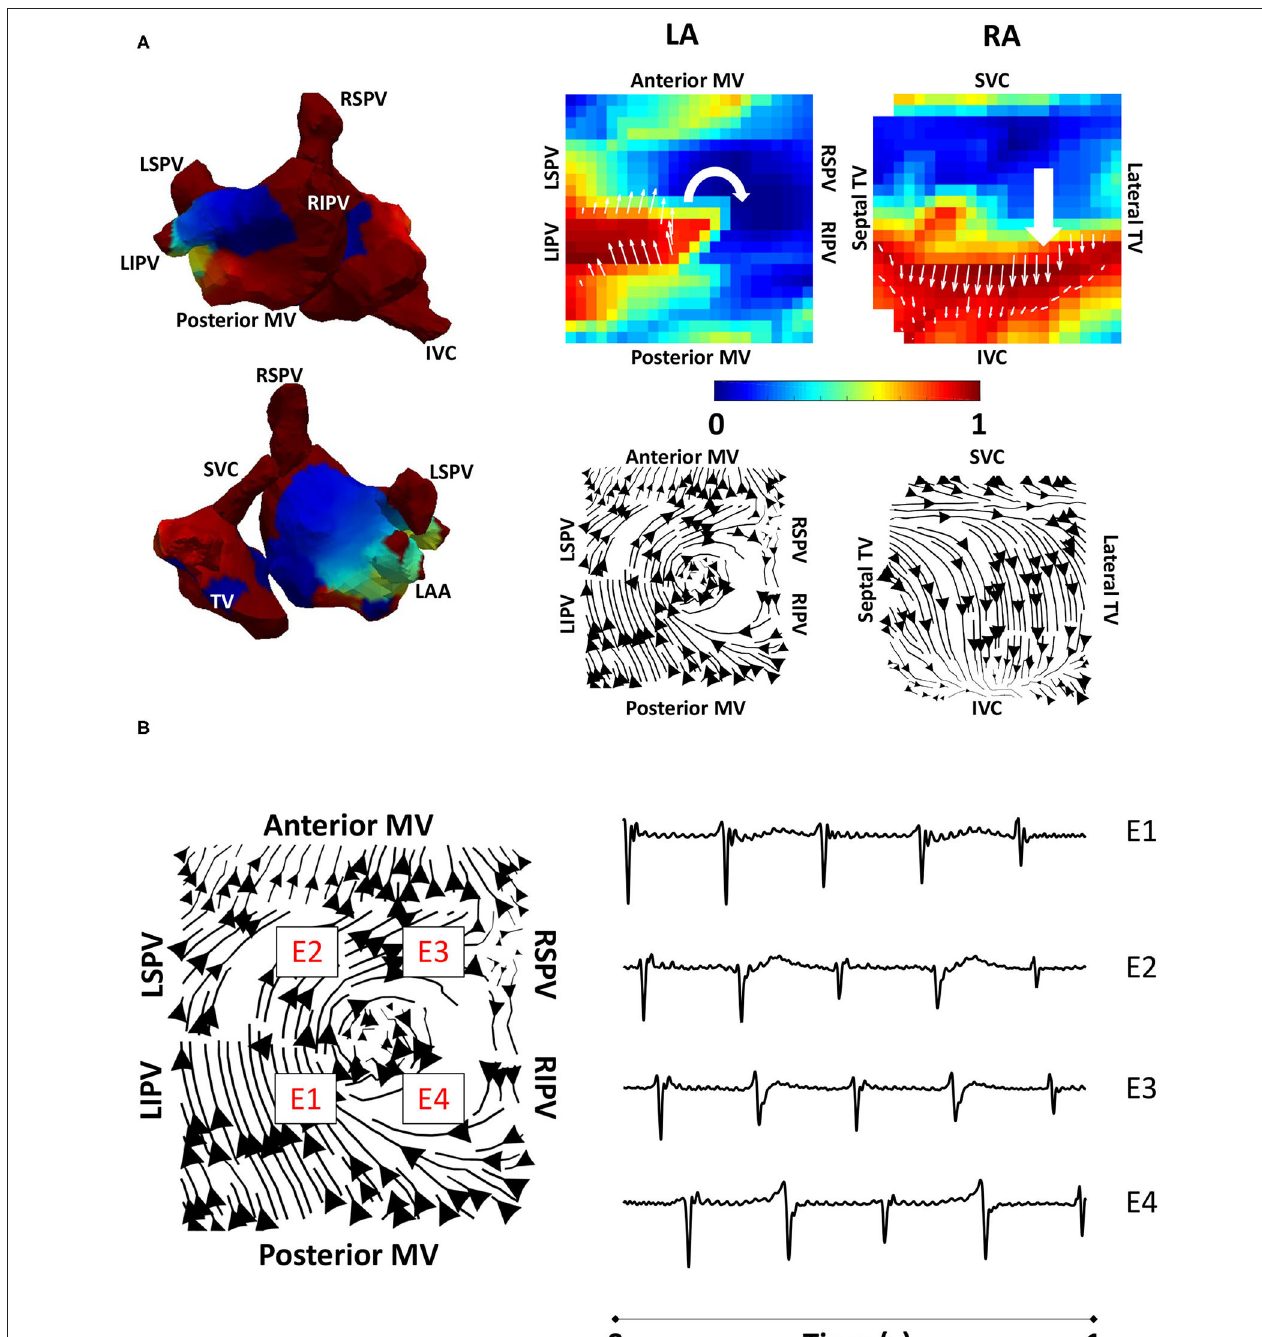
FIGURE 4 | Algorithm validation using clinical atrial tachycardia data. (A) Clinical atrial tachycardia phase maps, exhibiting re-entry on the LA posterior wall and passive RA activation are shown on the left of the figure. Normalised filtered derivative signals interpolated to a regular grid are shown on the top right for a single time point to show LA re-entry. Streamlines constructed from the average optical flow activation field for this clinical atrial tachycardia case demonstrate a re-entrant activation pattern on the LA posterior wall, and regular RA activation starting at the RA septal wall as it is activated from the LA. (B) Four LA basket electrograms are shown at the grid locations indicated by boxes with E1 to E4 on the streamline map. Locations E1-E4 are sequentially activated, demonstrating the presence of reentry. TV, tricuspid valve; SVC, superior vena cava; IVC, inferior vena cava; RAA, right atrial appendage; MV, mitral valve; LSPV, left superior pulmonary vein; LIPV, left inferior pulmonary vein; RIPV, right inferior pulmonary vein; RSPV, right superior pulmonary vein; LA, left atrium; RA, right atrium.